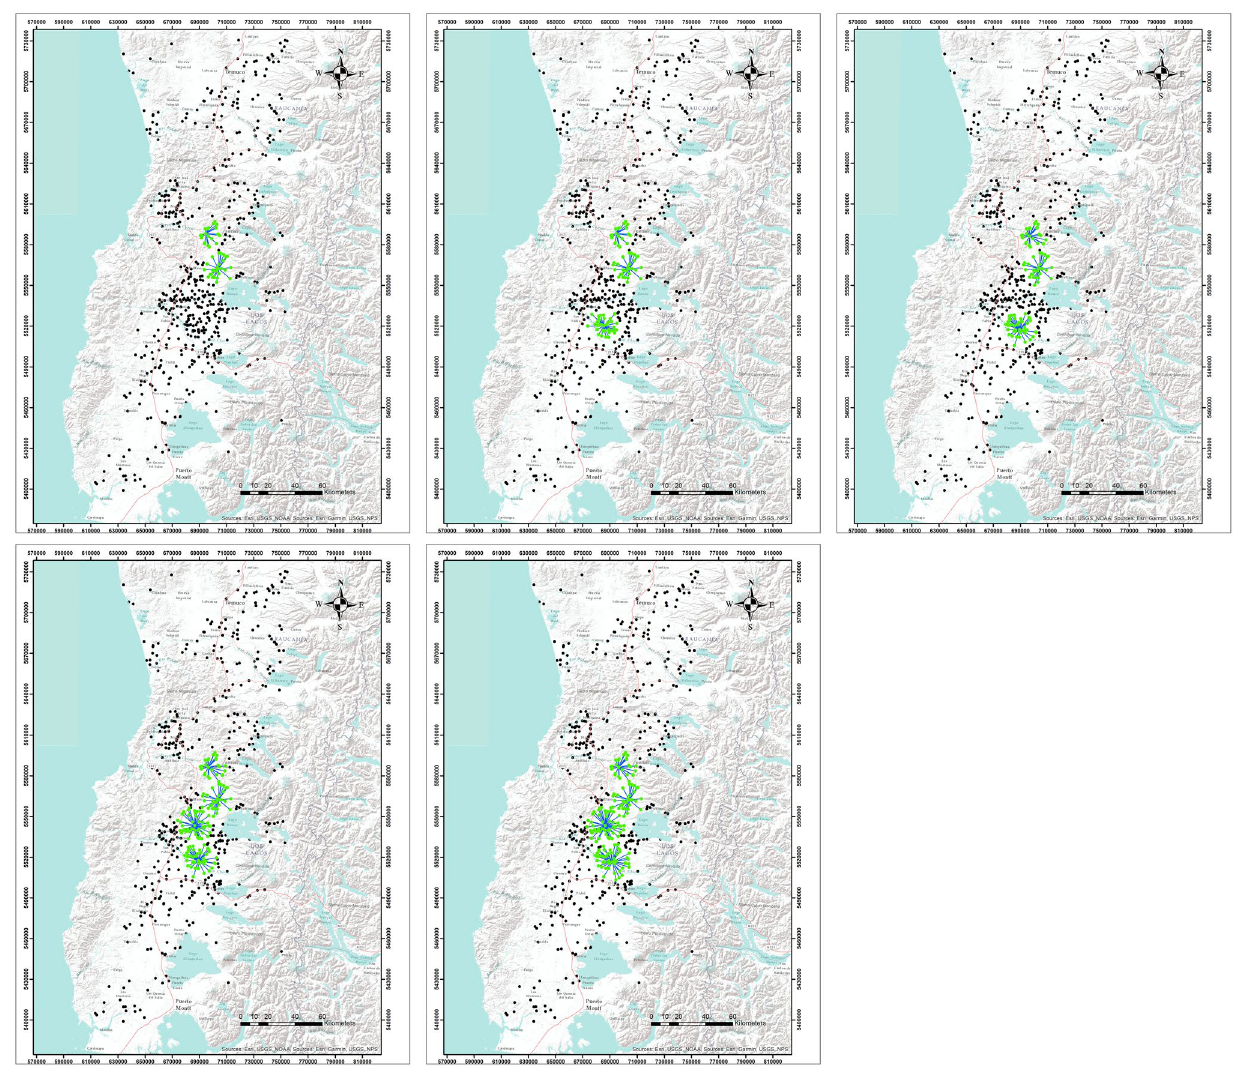
Fig. 13 Location of the configurations of the best combination found, with 70% biomass availability scenario, transport cost of 0.4 USD/tkm, and energy price of 92, 94, 96, 98, and 100 USD/MWh, in order of